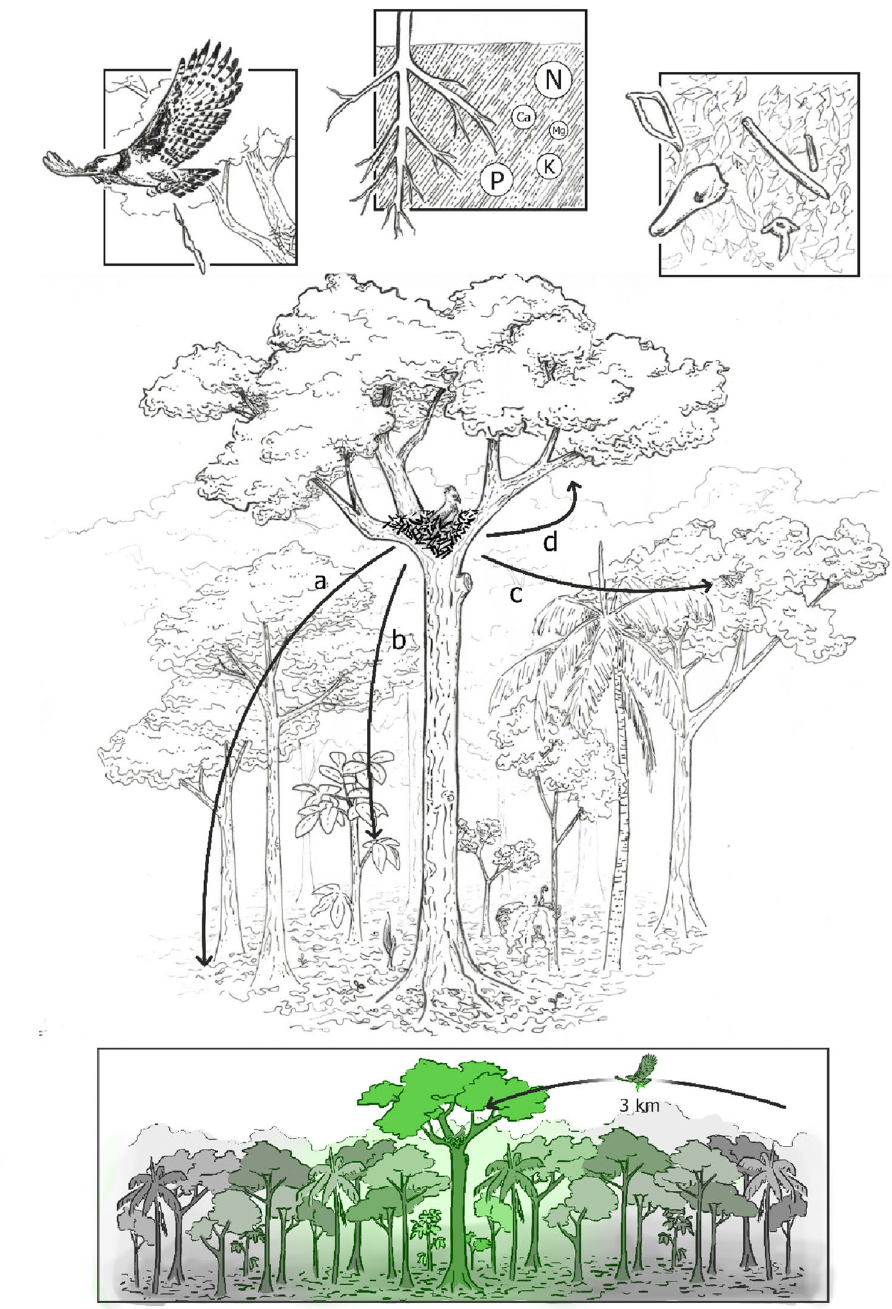
Figure 2. Schematic representation of the nutrient concentration role of nesting harpy eagles through central- place prey carcass and excreta deposition on different vegetation strata, including soil ( a ), the understorey foliage ( b ), canopy ( c ) and the nest tree itself. Lower panel represents the landscape-scale dynamic of nutrient concentration from commuting distances of up to 3 km from the nest. Magnitude of nutrient concentration is indicated by increasingly green colours. Illustration: Paula